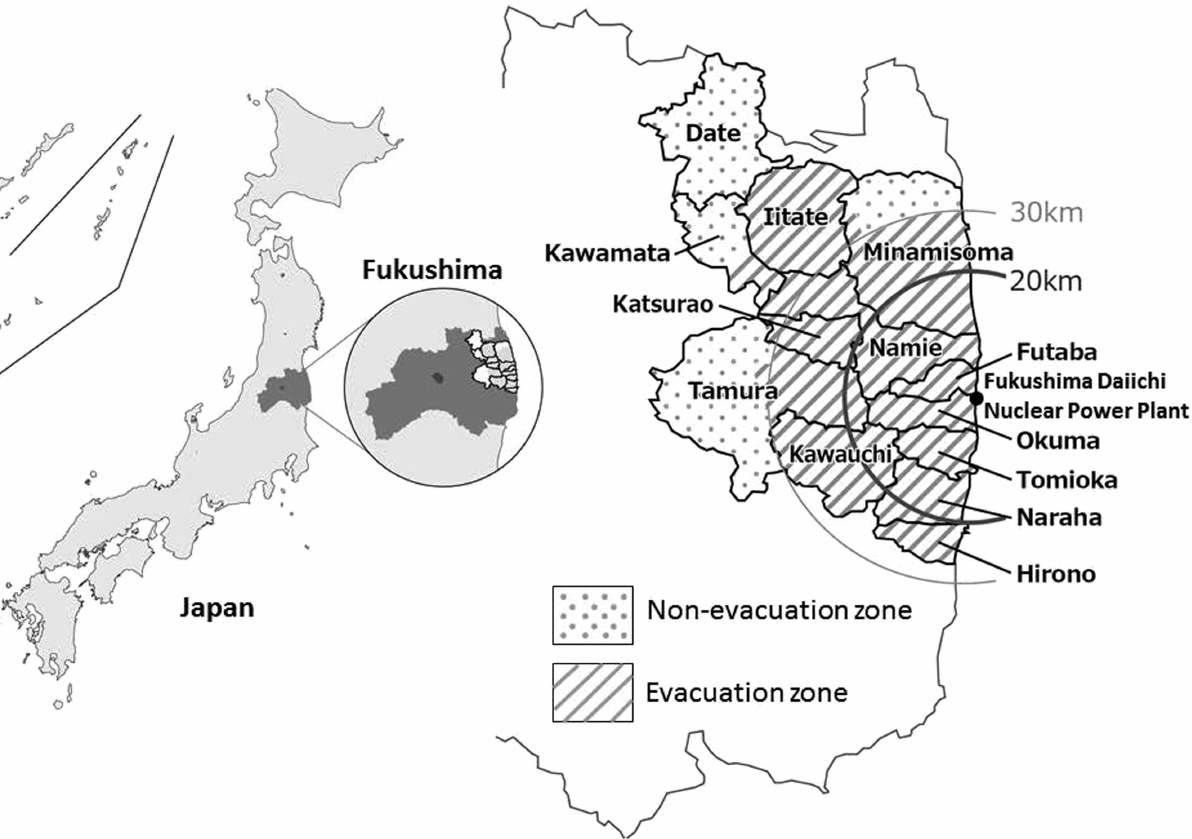
Fig. 1. Map of the evacuee zone, non-evacuee zone, and the Tokyo Daiichi Nuclear Power